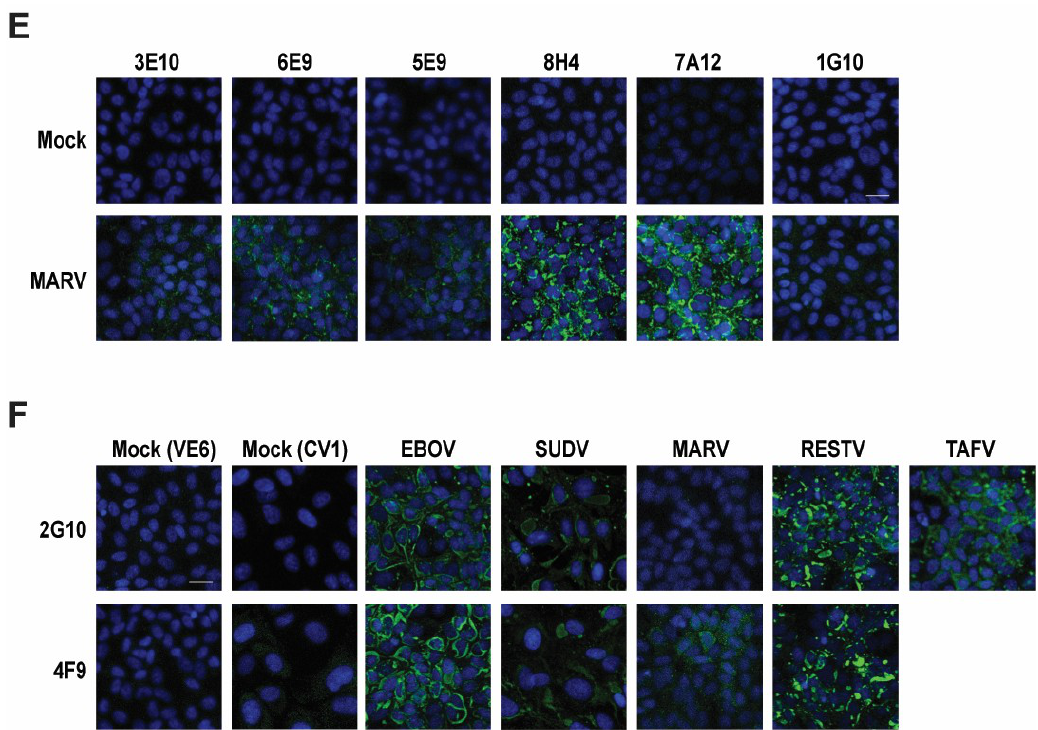
Figure 3 . Anti-NP filovirus mAbs detected the native filovirus NP in confocal microscopy (CM). In CM, the cells were infected with a multiplicity of infection (MOI) of 3, fixed and permeabilized at 48 h post-infection (hpi), and stained with different anti-filovirus NP mAbs; the nuclei were stained with DAPI, and finally filovirus NP expressions were detected by treating with Alexa 488 secondary anti-mouse antibodies (Abs). Mock infection controls were also maintained with both primary and secondary Ab staining. ( A ) Vero E6 cells were infected with EBOV treated with 15D10 and 6E5 mAbs. ( B ) CV1 cells were infected with SUDV and treated with 3F12, 11G9, 6G5, and 12F12 mAbs. ( C ) Vero E6 cells were infected with RESTV and stained with primary 2A10 and 7E7 mAbs. ( D ) Vero E6 cells were infected with TAFV and treated with 4B10, 2A10, 8G9, and 1H3 mAbs. (E) Vero E6 were infected with MARV and treated with 3E10, 6E9, 5E9, 8H4, 7A12, and 1G10 mAbs. ( F ) CV1 cells were infected with SUDV, and Vero E6 cells were infected with EBOV, MARV, RESTV, and TAFV; therefore, they were treated separately with 2G10 and 4F9 to check cross reactivities against different filoviruses. The scale bar represents 20 µ